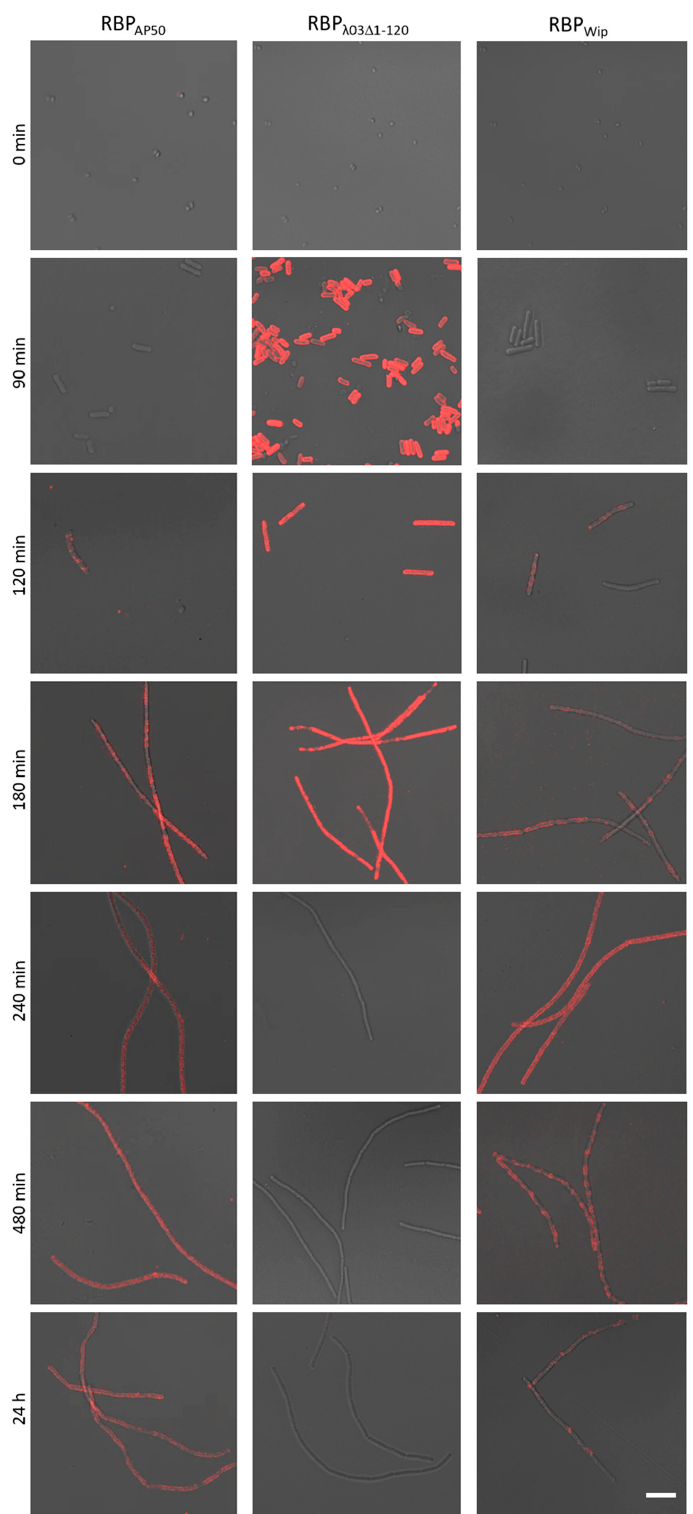
Figure 3. Binding of red-fluorescent RBP reporters to B. anthracis cells at di ff erent time points during culture growth phases. Tested were germinating B. anthracis Sterne spores over a period of 24 h. Representative time points are shown for binding of the three reporters RBP AP50 , RBP λ 03 ∆ 1-120 and RBP Wip recorded in merged light and fluorescence channels. Scale bar: 10 µ